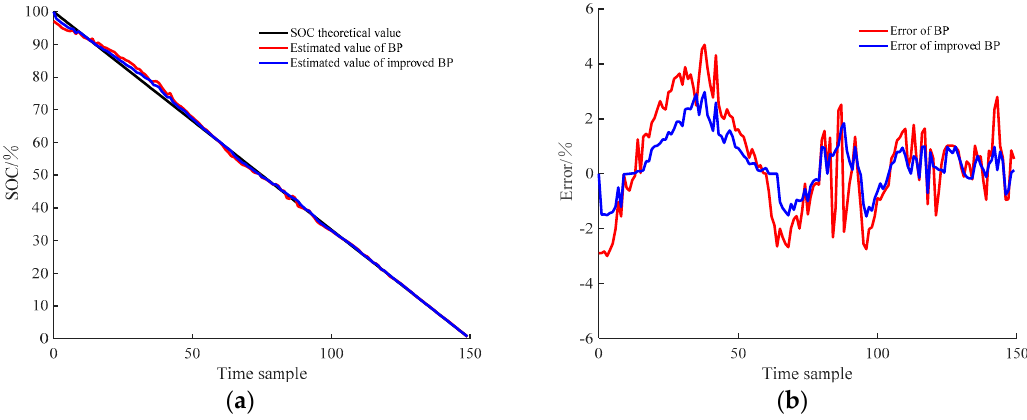
Figure 7. The estimation accuracy of the state of charge (SOC) before and after the algorithm is improved: ( a ) Comparison curves between different estimation methods and SOC theoretical values; ( b ) the error curves of the two estimation methods compared with the theoretical values.